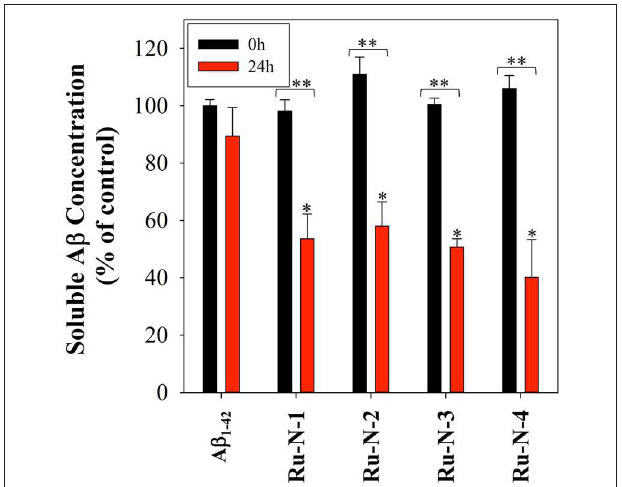
FIGURE 7 | Bradford assay of 60 µ M A β 1 − 42 in the presence of 1 eq. of all four Ru-N complexes in PBS buffer (0.01M, pH 7.4) at 0 hour (black) and after 24h of incubation with agitation at 37 ◦ C (red). Samples were centrifuged at 14,000g for 5min prior to absorbance measurement. Statistically significant difference between *A β 1 − 42 only and in the presence of the complexes ( Ru-N-2 , p = 0.0025, Ru-N-1 and Ru-N-3 , p = 0.0005, and Ru-N-4 , p < 0.0001) **0 and 24h time point ( Ru-N-1 , p = 0.0003, and Ru-N-2 , Ru-N-3, and Ru-N-4 , p < 0.0001). Calculated using 2 way